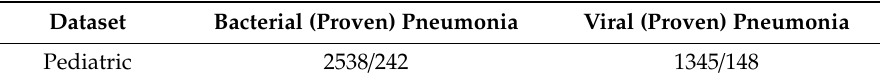
Table 1. Baseline dataset characteristics. Numerator and denominator denote the number of train and test data, respectively. Note that this dataset predates the onset of SARS-CoV2 virus, and therefore the viral pneumonia is of non-COVID-19 type.